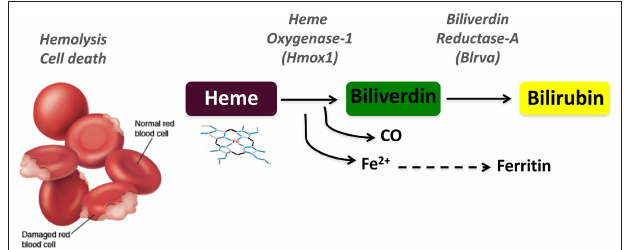
FIGURE 1 | Schematic representation of the heme degradation pathway. Damaged red blood cells release free heme, which is converted to biliverdin by heme oxygenase-1 (HO-1, HMOX1 ) in a reaction that generates carbon monoxide (CO) and iron (Fe 2 + ). Biliverdin is in turn converted to bilirubin by biliverdin reductase A